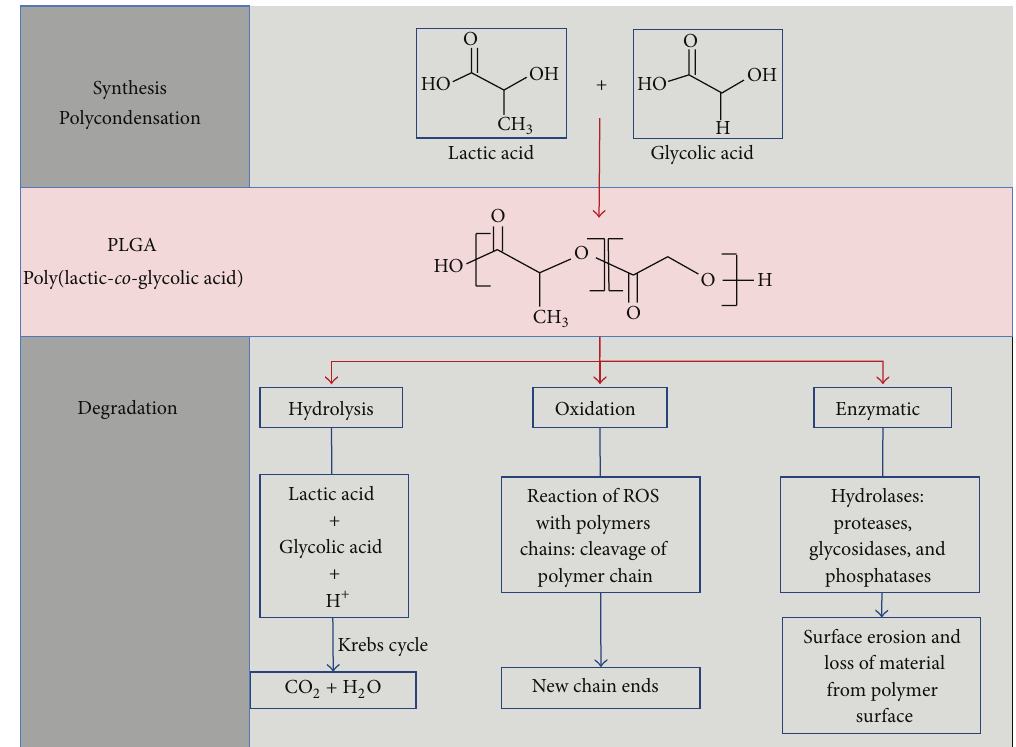
Figure 1: PLGA, poly(lactic- co -glycolic acid), synthesis and degradation. The main reaction used to obtain PLGA is ring opening polymerization and polycondensation of lactic and glycolic acids. Most important mechanisms of PLGA degradation involve hydrolysis, oxidation, and enzymatic degradation.